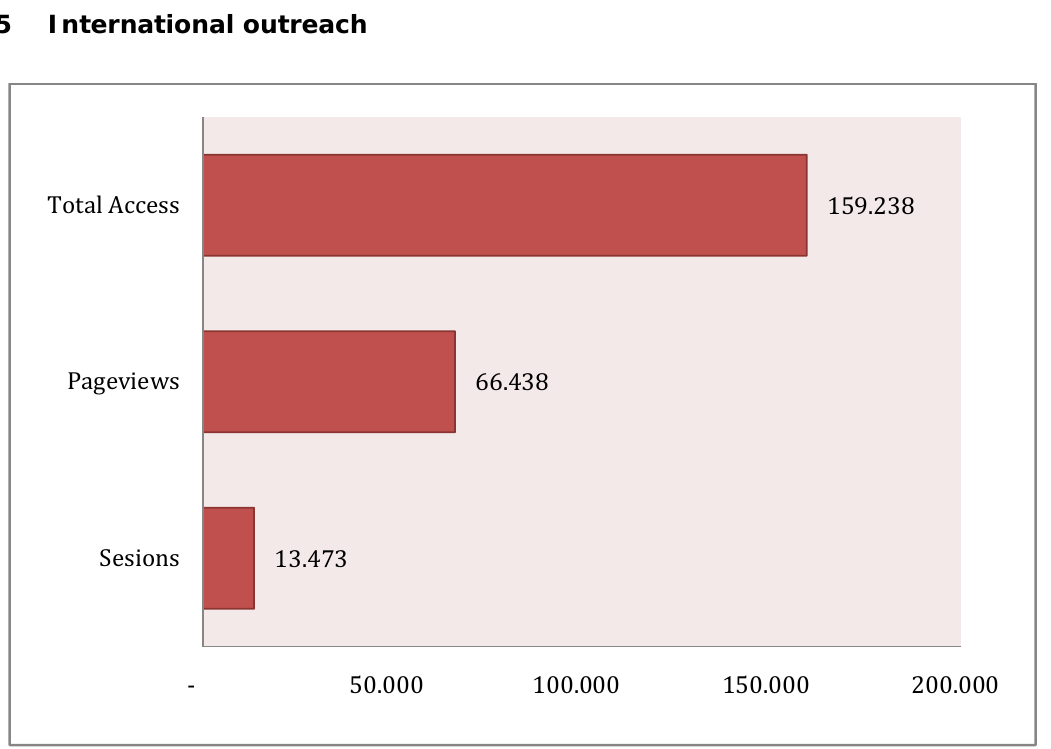
Figure 3. “Visibility of the journal in